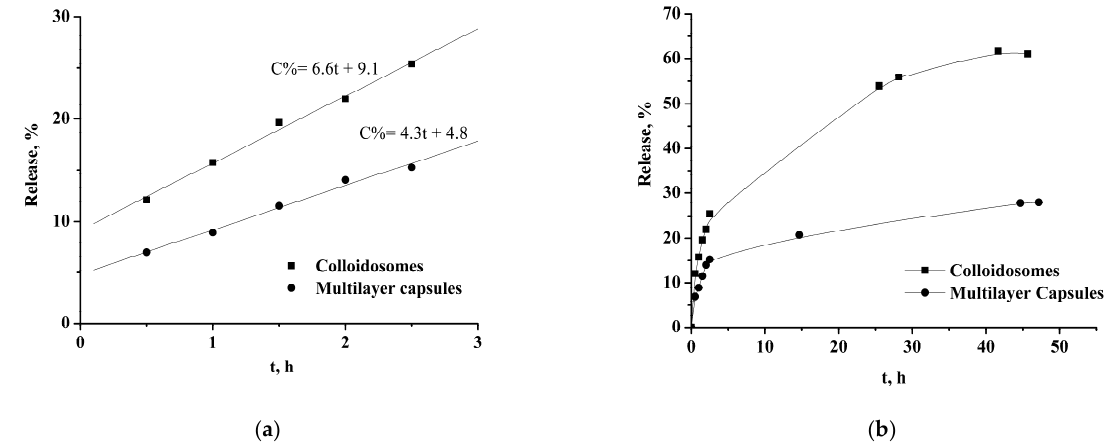
Figure 10. The release of TQ from colloidosomes and multilayer capsules at 2.5 h ( a ) and 45 h ( b ).